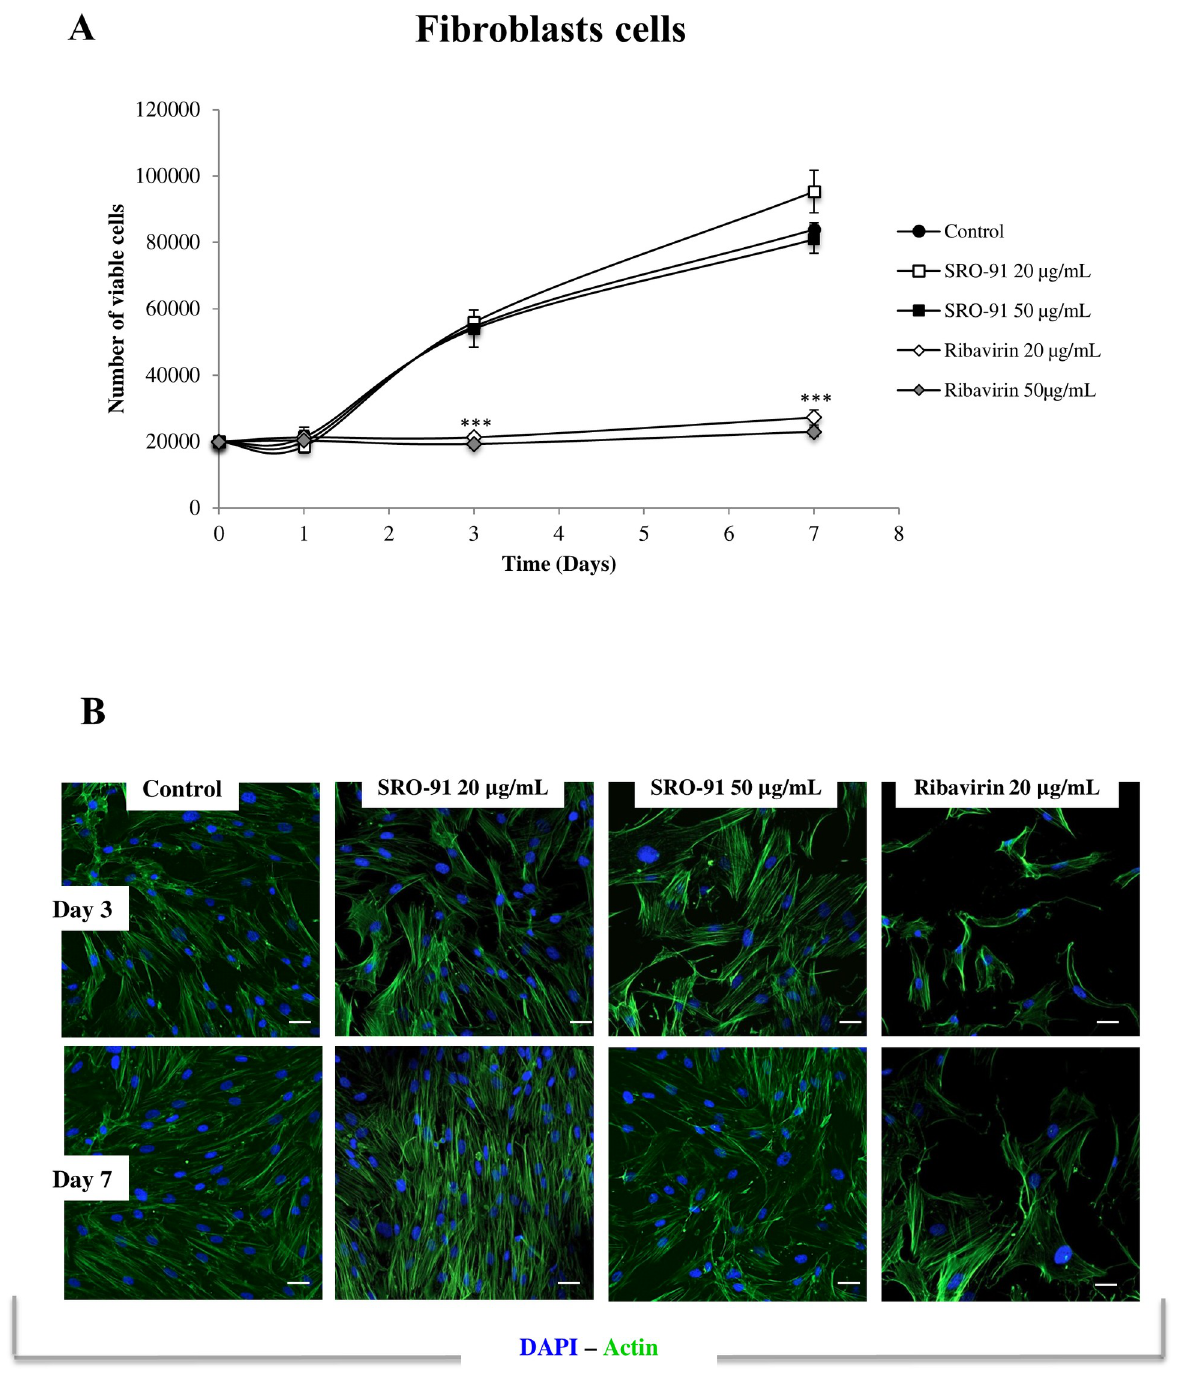
Fig 11. Viability and cell morphology of healthy fibroblasts BJ cells after SRO-91 or ribavirin treatment. (A) Fibroblasts BJ cells were exposed to ribavirin analog SRO-91 or ribavirin at 0, 20 or 50 μ g/mL for 7 days of culture. The number of viable cells was measured daily by the trypan-blue exclusion test. Results are representative of at least three independent experiments performed in triplicate and are expressed as mean ± standard deviation. P-values were calculated by Paired one-way ANOVA test ( ��� P < 0.001). (B) Immunofluorescent staining of actin cytoskeleton expressed by fibroblasts BJ cells after SRO-91 or ribavirin treatment or without treatment (control). Cell nuclei were stained with DAPI. Staining was examined with laser scanning confocal microscopy. Scale bar is 50 μ m.